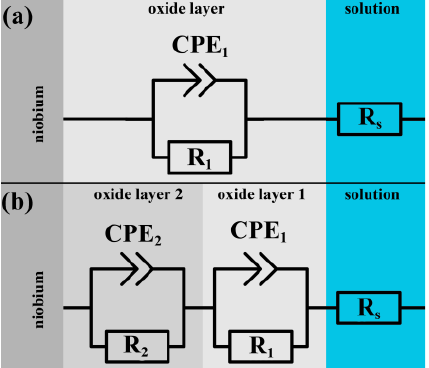
Figure 5. Used equivalent circuits for EIS measurements ( a ) single layer, ( b ) double layer.